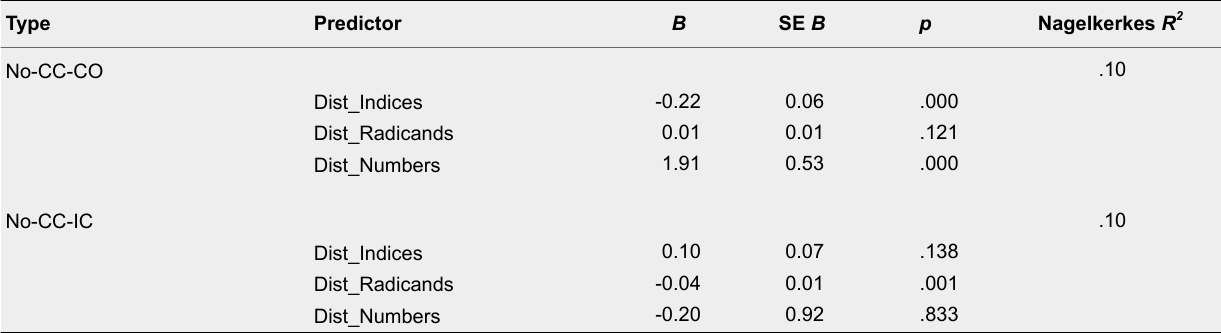
Results of the Multiple Binary Logistic Regression Analysis With Numerical Distances as Predictors and Accuracy as the Depending Variable, for Each Type of